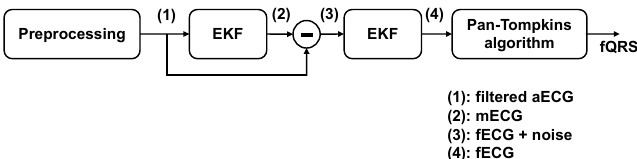
Figure 2. Fetal QRS (fQRS) detection process: (1) Preprocessing step with low pass filter utilized; (2) extended Kalman filter (EKF) applied for maternal ECG (mECG) extraction; (3) mECG subtracted from filtered aECG signal and EKF used for fetal ECG (fECG) extraction; (4) The Pan-Tompkins algorithm applied for fQRS detection.